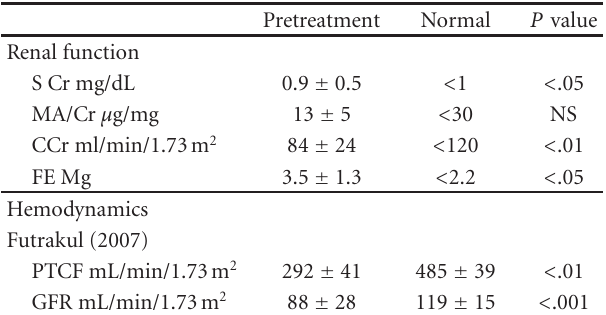
Figure 1: Comparison between conventional and newdiagnostic markers. Table 1: Clinical findings in early stage of type 2 DN (normoalbu-